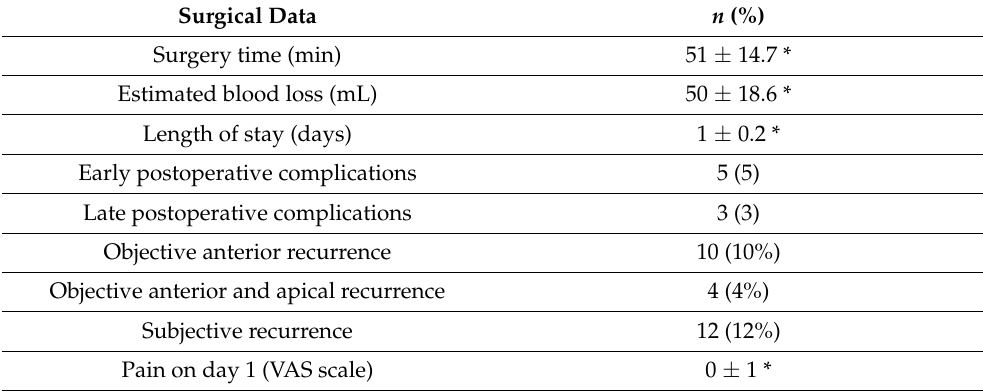
Table 2. Surgical data.